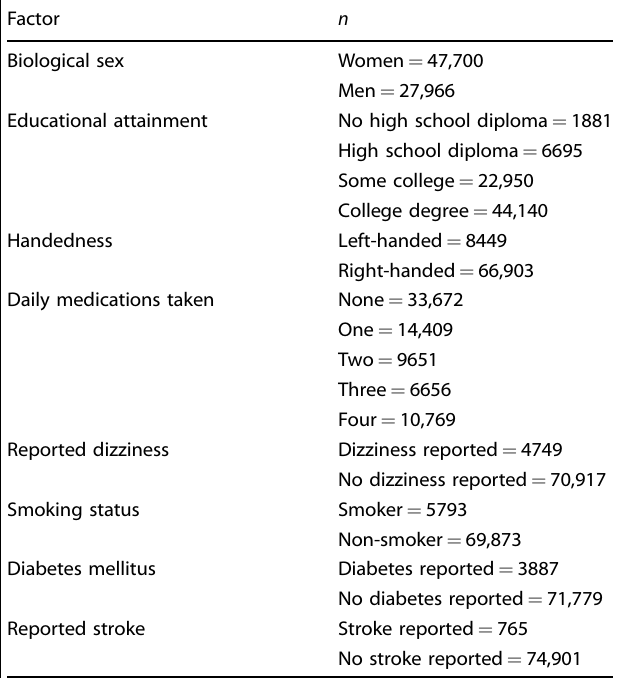
Table 2. Summary of MindCrowd ’ s sample sizes ( n